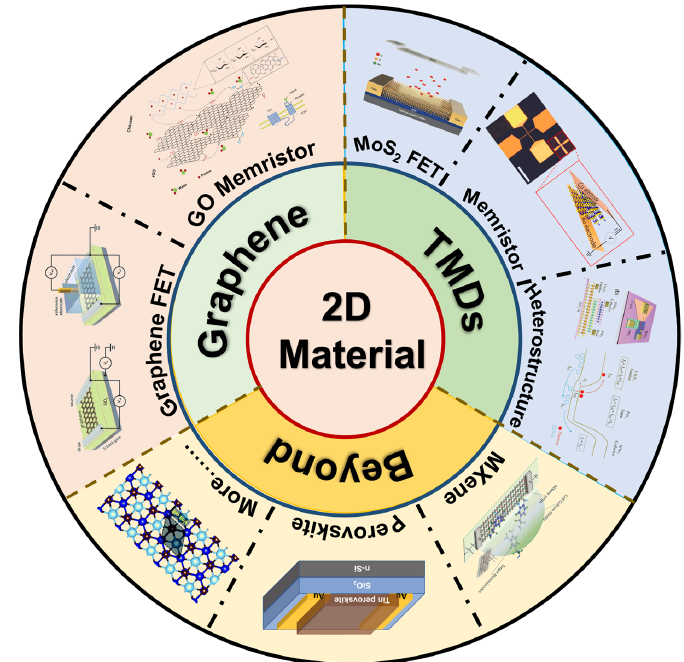
Figure 4. Representative 2D materials used in the fabrication of flexible artificial synapses; 2D ma- terials are frequently used as the channel materials of transistor and resistive layers of memristors